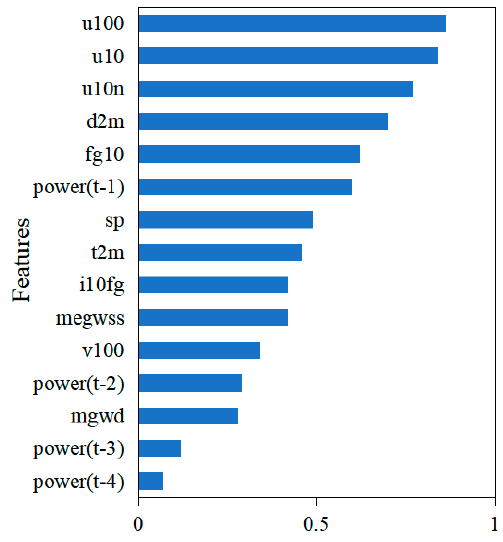
Figure 6. Histogram of feature importance.